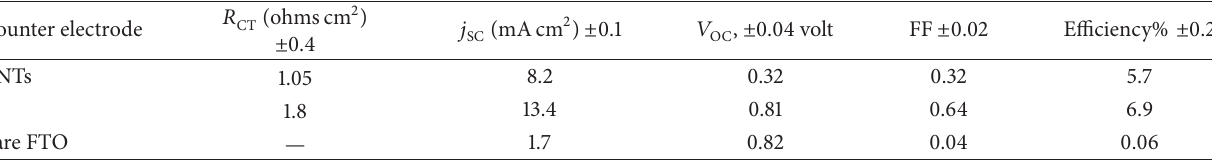
Table 5: Current-voltage characteristics of DSSC with carbon nanotubes as counter electrode: measurements have been carried out under 0.75 sun illumination.